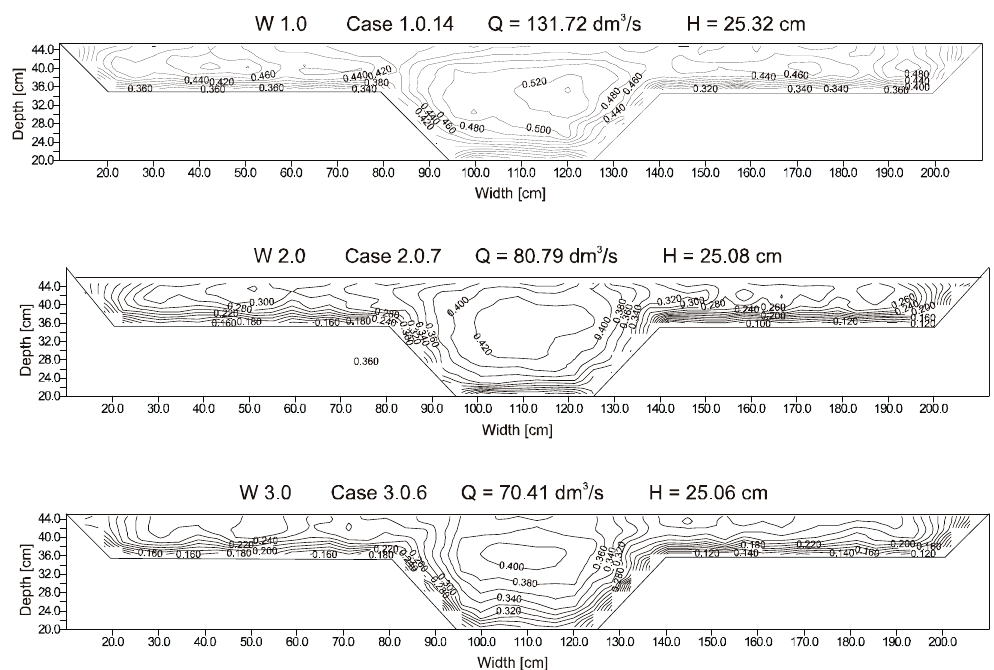
Figure 4. Isovels in the cross-section of the channel for selected experiments in different experimental variants at similar depth.